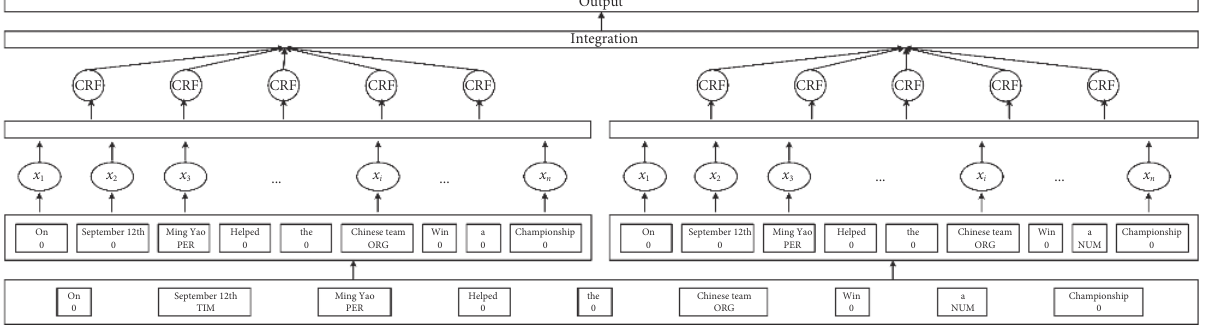
Fig. 4 Structure of the integrated learning